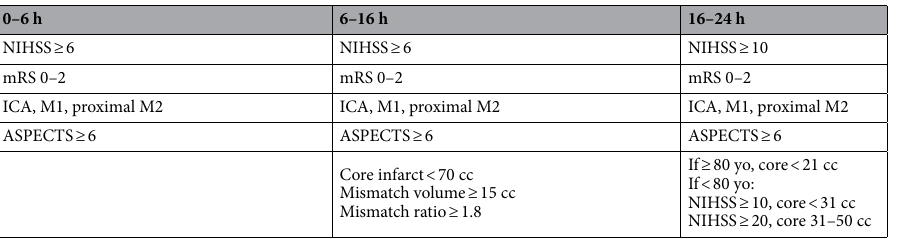
Table 1. Healthcare system endovascular therapy guideline to determine candidacy for mechanical thrombectomy. NIHSS National Institute of Health Stroke Scale, mRS Modified Rankin Scale score, ICA Internal carotid artery. M1 and M2 Branches of middle cerebral artery. ASPECTS Alberta stroke program early computed tomography